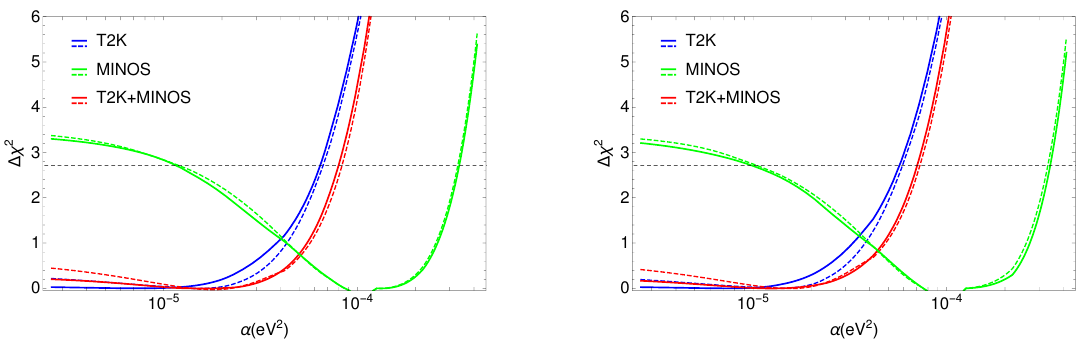
Figure 8 . Curves showing (cid:1) (cid:31) 2 as a function of (cid:11) for T2K (blue), MINOS (green) and the full T2K and MINOS combination (red). Dashed lines show the same information, with the additional pull function from reactor data. We show the scalar (pseudoscalar) scenario on the left (right)